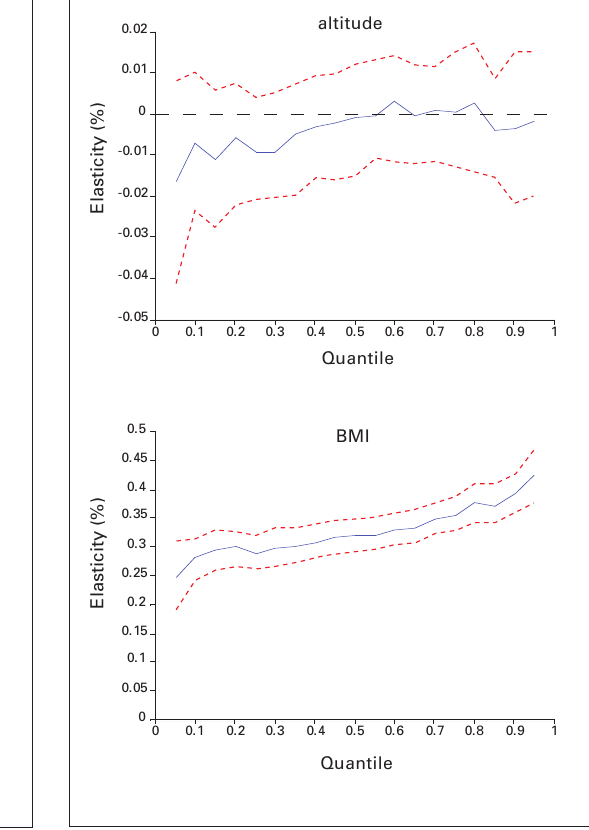
Figure 5 The impact of income and altitude is not significant for all quantiles. Better sports performance reduces increasingly individual cholesterol the higher the latter is (significant only for individual values above the 35 th per- centile). BMI has a significantly positive influence on cholesterol for all